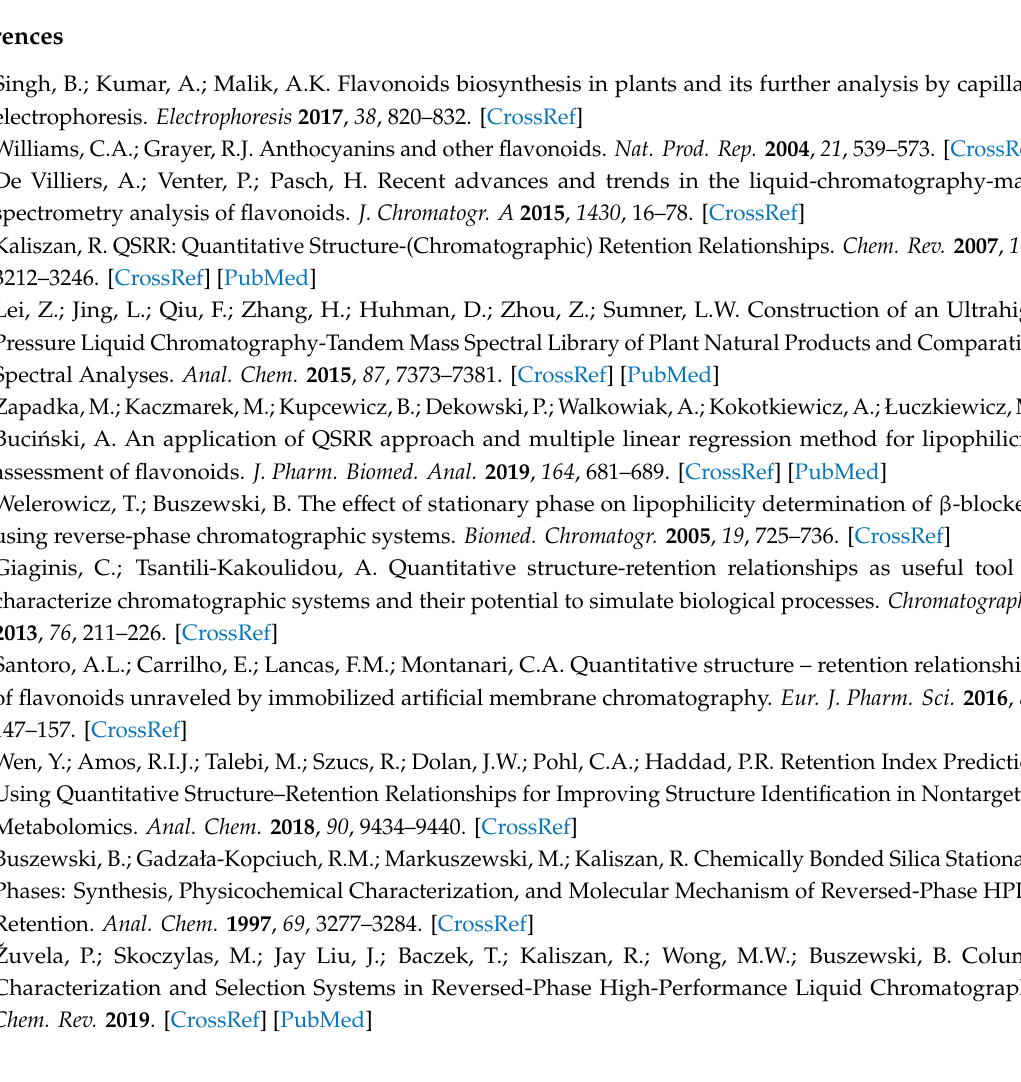
Supplementary Materials: The following are available online at http: // www.mdpi.com / 1422-0067 / 21 / 6 / 2053 / s1, (Ref S1: full Gaussian 16 citation, Table S1: summary of the experimental retention values of flavonoids on three stationary phases and the values of the QM parameters employed for QSRR modelling, Figures S1–S3: MRM transitions and retention times for flavonoids analyzed on three chromatographic columns, Figure S4: optimization of latent variables for the final consensus GA-PLS models for: (A) Kinetex C-18 column, (B) Kinetex F5 column, (C) IAM.PC.DD2 column, Figure S5: graphical depiction of the optimized 3D molecular structures of all the